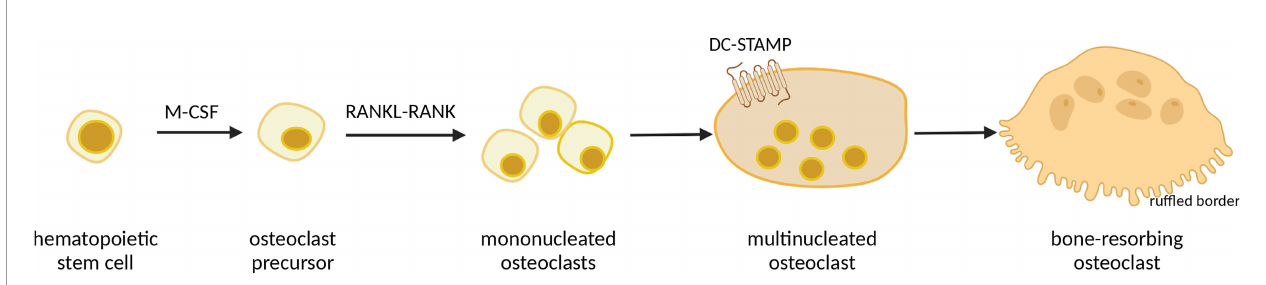
FIGURE 1 | Schematic representation of osteoclast differentiation. Macrophage Colony Stimulating Factor (M-CSF) induces hematopoietic stem cells to become osteoclast precursors, which, under in fl uence of Receptor-Activated Nuclear k B ligand (RANKL) develop into mononucleated osteoclasts. Further, mononucleated osteoclasts undergo fusion, mediated by DC-STAMP protein, into giant multinucleated osteoclasts, which then, upon interaction with osteoblasts, differentiate into mature bone-resorbing osteoclasts with ruf fl ed border, which secrete acids and matrix metalloproteinases. Image created with BioRender.com.